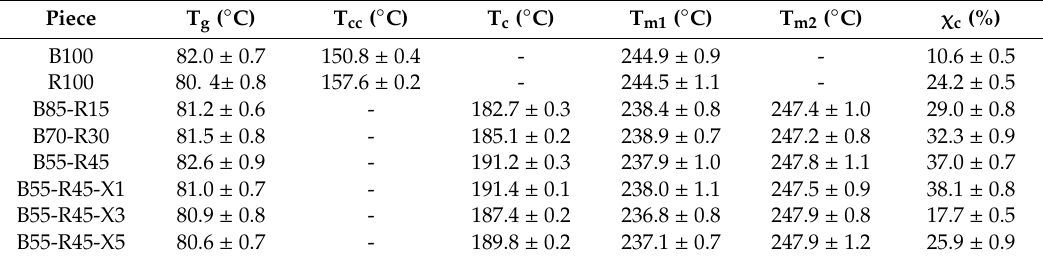
Figure 4. Differential scanning calorimetry (DSC) curves during cooling ( a ) and second heating ( b ) of the injection-molded pieces of the partially bio-based and recycled polyethylene terephthalate (bio-PET/r-PET) blends. Table 4. Summary of the main thermal properties of the injection-molded pieces of the partially bio-based and recycled polyethylene terephthalate (bio-PET/r-PET) blends in terms of glass transition temperature (T g ), cold crystallization temperature (T cc ), crystallization temperature (T c ), melting temperature (T m ), and degree of crystallinity ( χ c ).